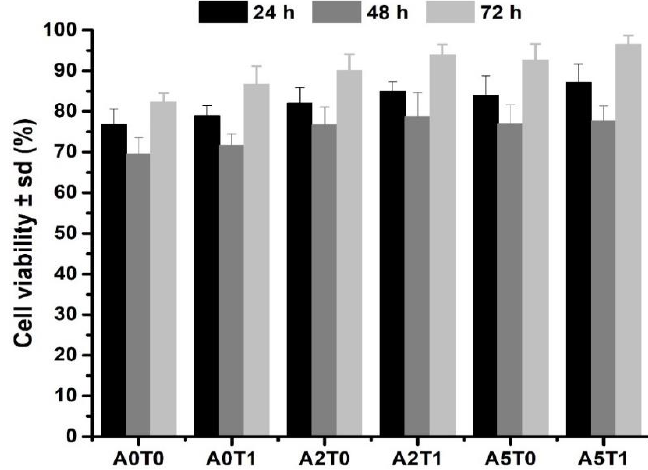
Figure 6. Cell viability assay of the samples at the 24, 48 and 72 h.